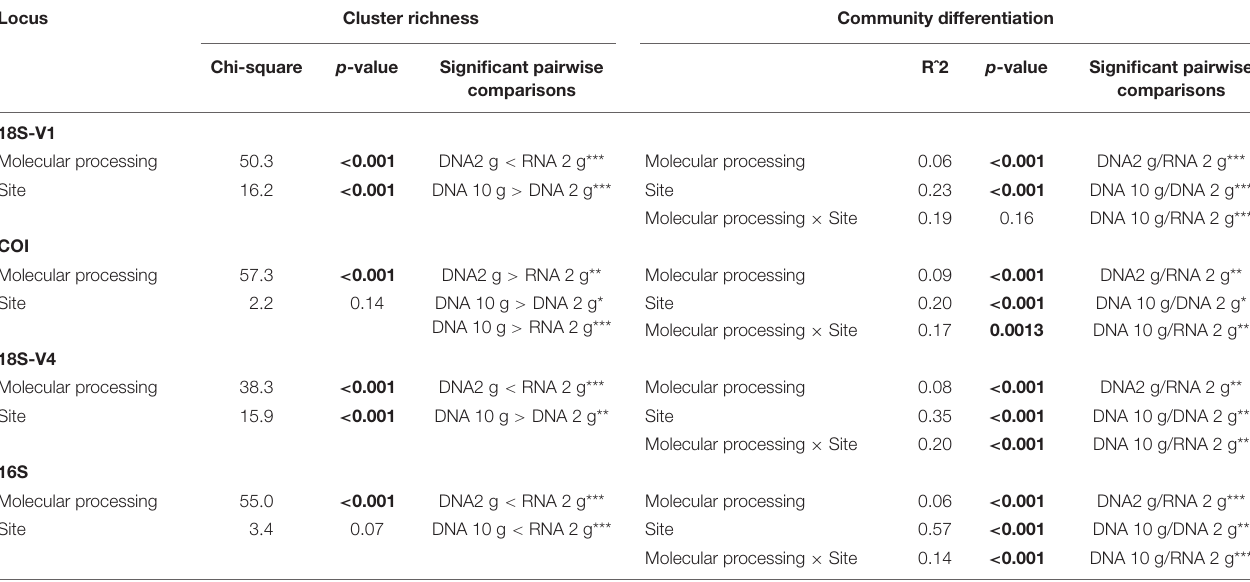
TABLE 1 | Changes in cluster richness and community structures with molecular processing method (DNA 10 g: DNA extracts from ∼ 10 g of sediment with the PowerMax Soil kit; DNA/RNA 2 g: DNA/RNA extracts from ∼ 2 g of sediment with the RNeasy PowerSoil kit) and site for the four studied genes. Locus